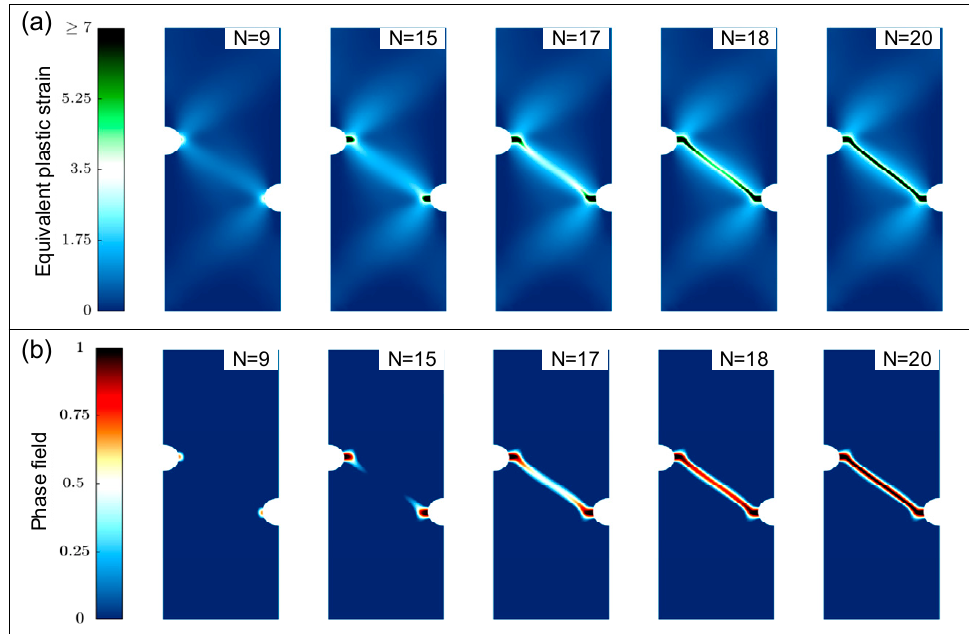
Figure 5. Macroscale ductile fracture. ( a ) Equivalent plastic strain fi eld and ( b ) phase fi eld [37].